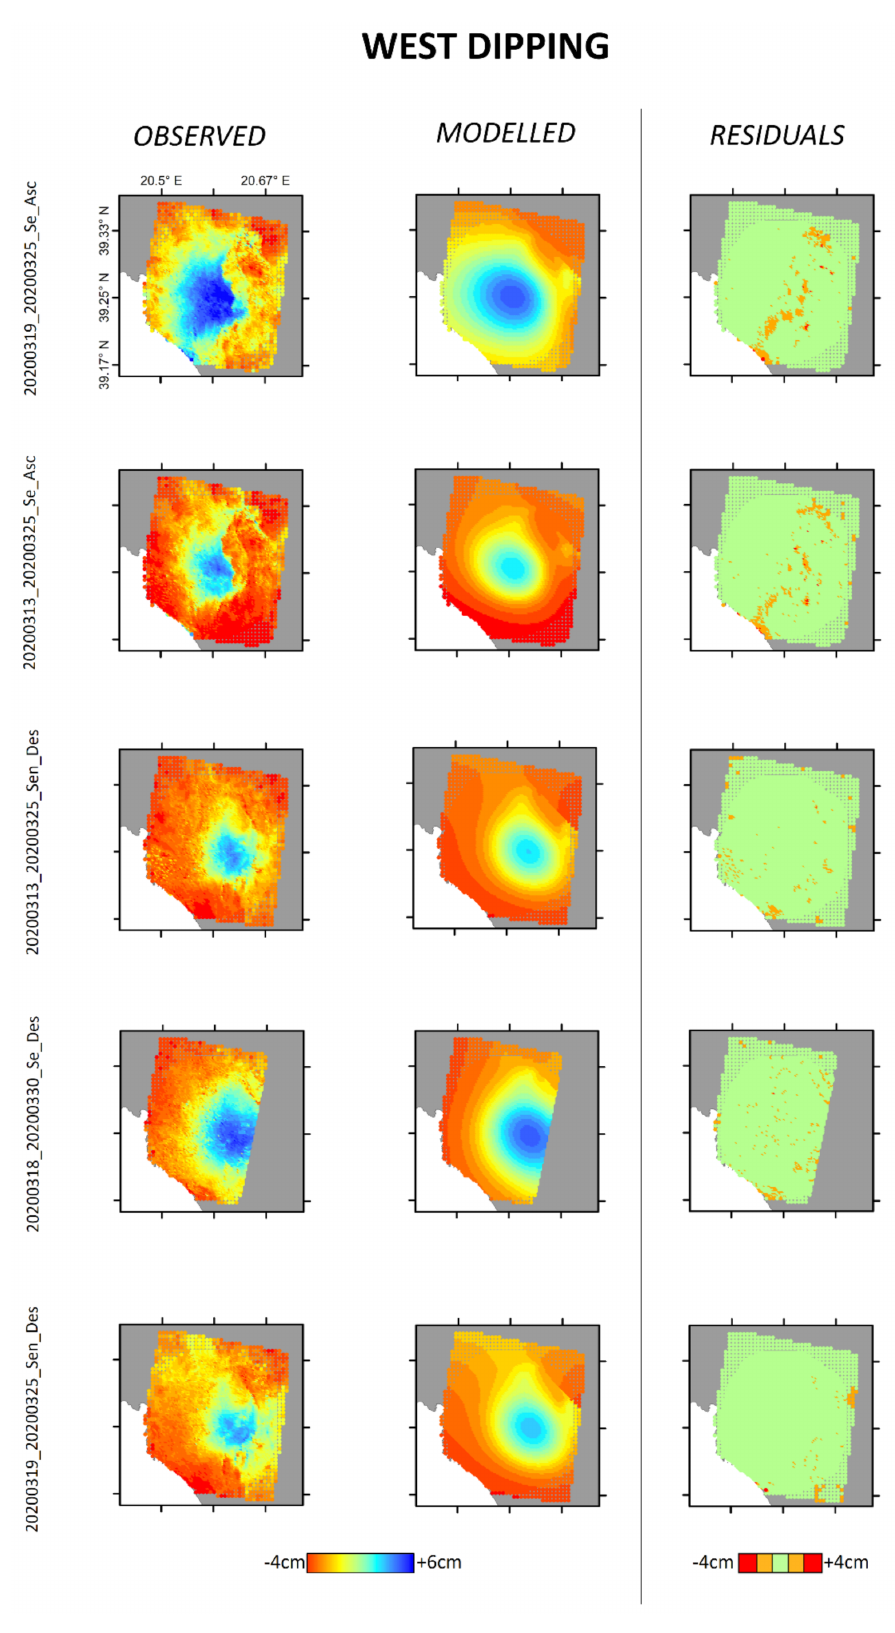
Figure 8. Comparison between observed and modelled InSAR deformation results of the linear inversion, for a west-dipping